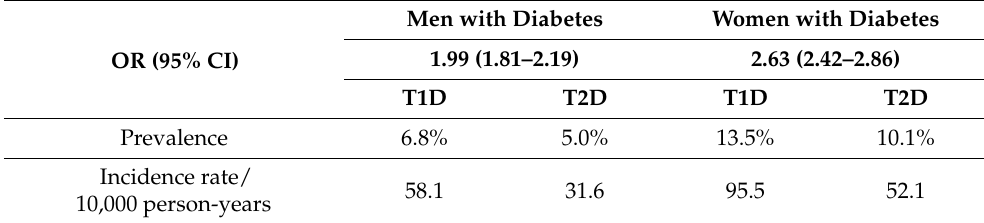
Table 1. Risk for CTS in diabetes related to sex.